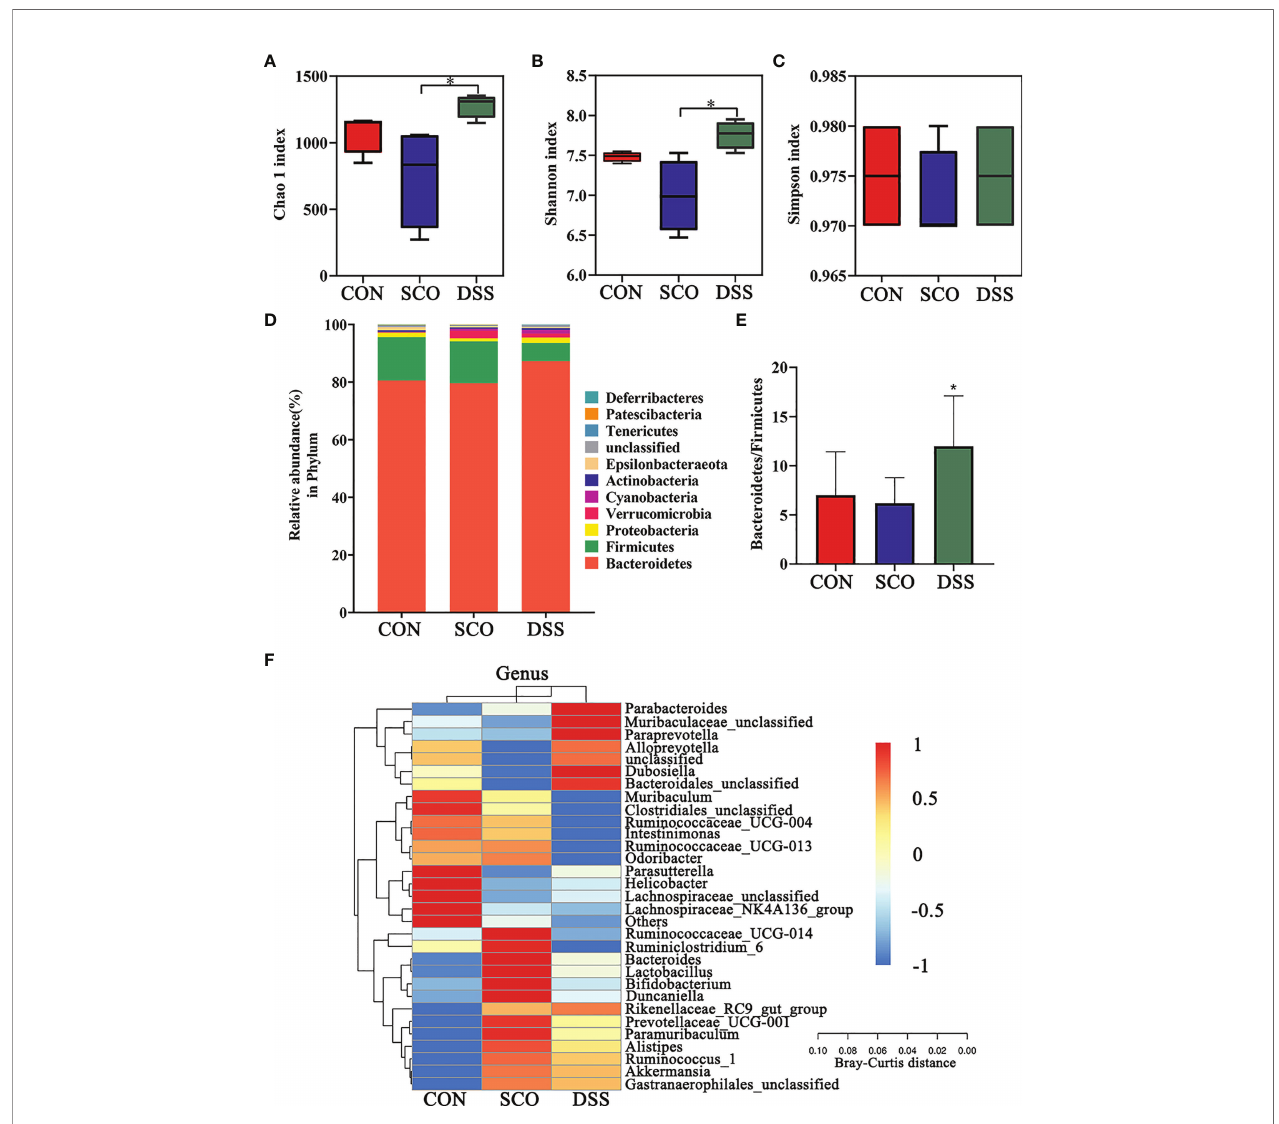
FIGURE 3 | Evaluation of 16S rRNA gene sequence analyzes of the CON, SCO and DSS groups: (A, B) a -diversity Chao1 (A) , Shannon indices (B) and Simpson index (C) in each group, (D) . Correlation heatmap of the gut microbiota and metabolite phylum (n = 8). (E) The ratio of Bacteroidetes/Firmicutes . (F) Correlation heatmap of gut microbiota and metabolite genera (top 30 general analysis) (n = 8). * p < 0.05 vs.